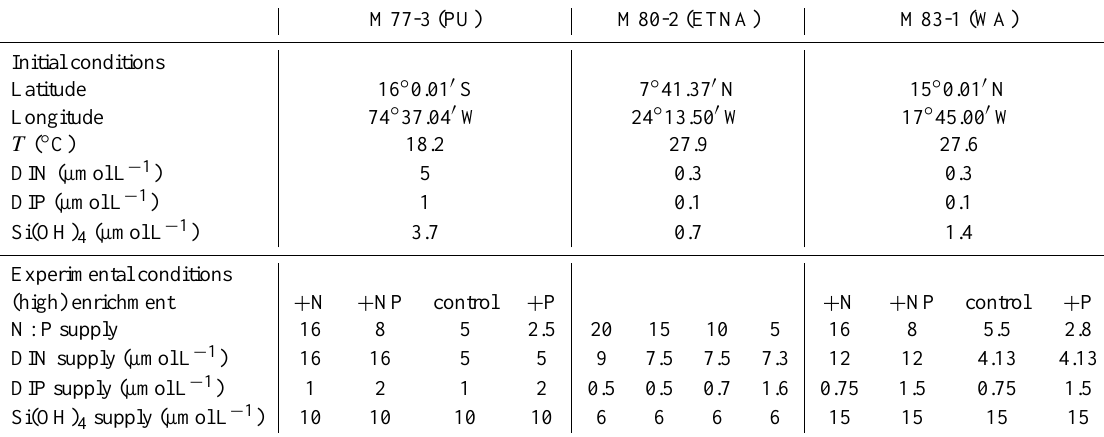
Table 1. Overview of mesocosm filling sites, initial and experimental conditions during the three